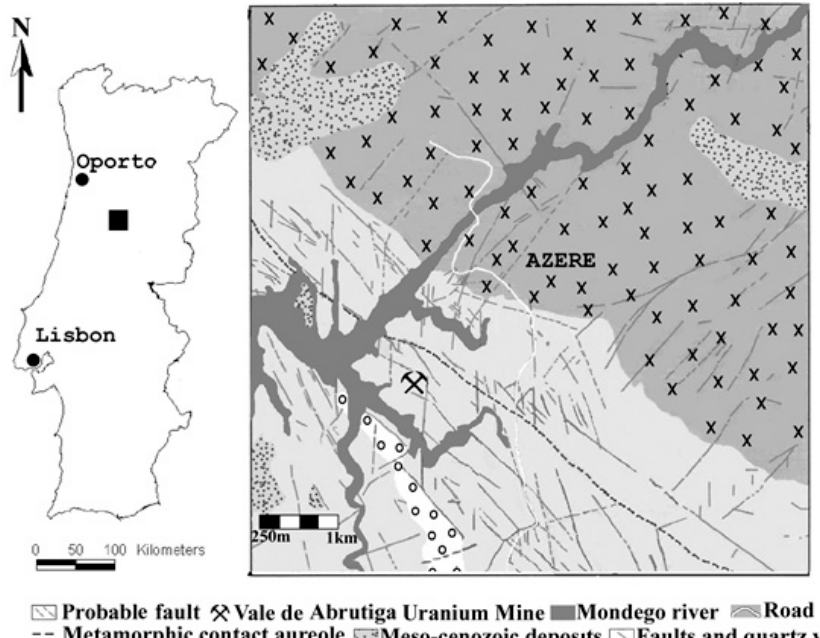
Figure 1. Location and geological map of the Variscan Beiras granite and related mineralized hydrothermal quartz veins.